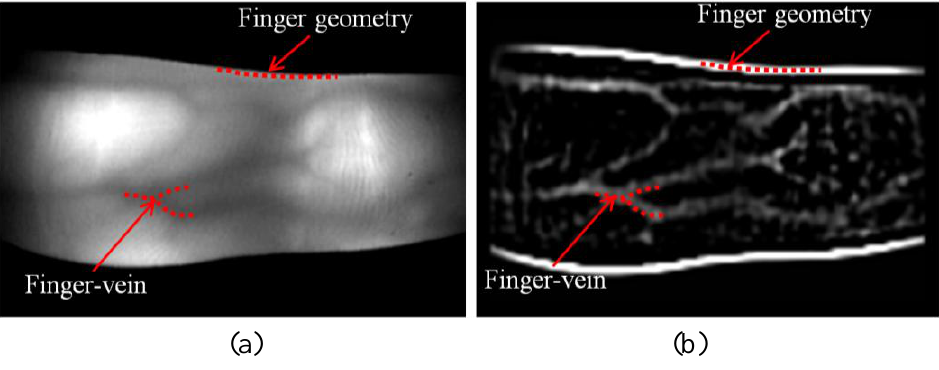
Figure 1. Example of finger geometry and finger veins components in (a) a captured IR finger image and (b) an image after modified Gaussian high-pass